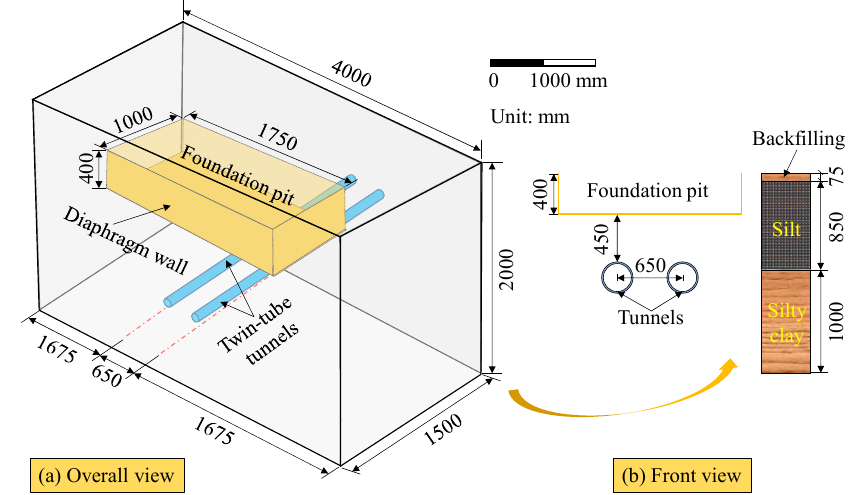
Figure 3. Layout and geometry of the model.